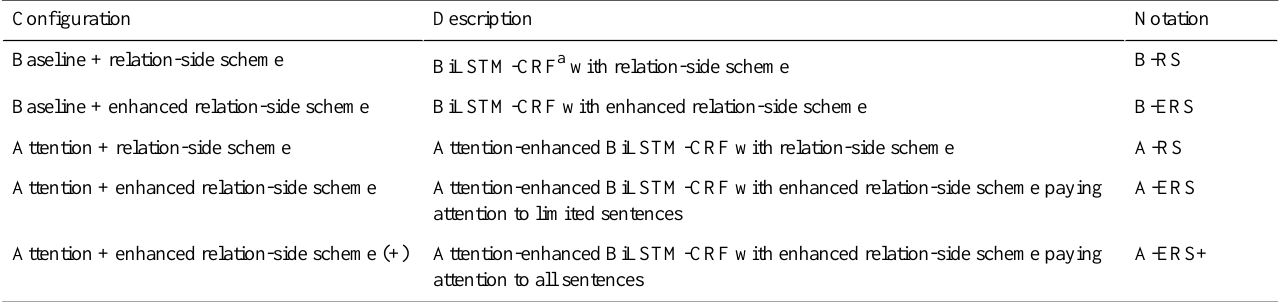
Table 2. Summary of the configurations studied in this work.